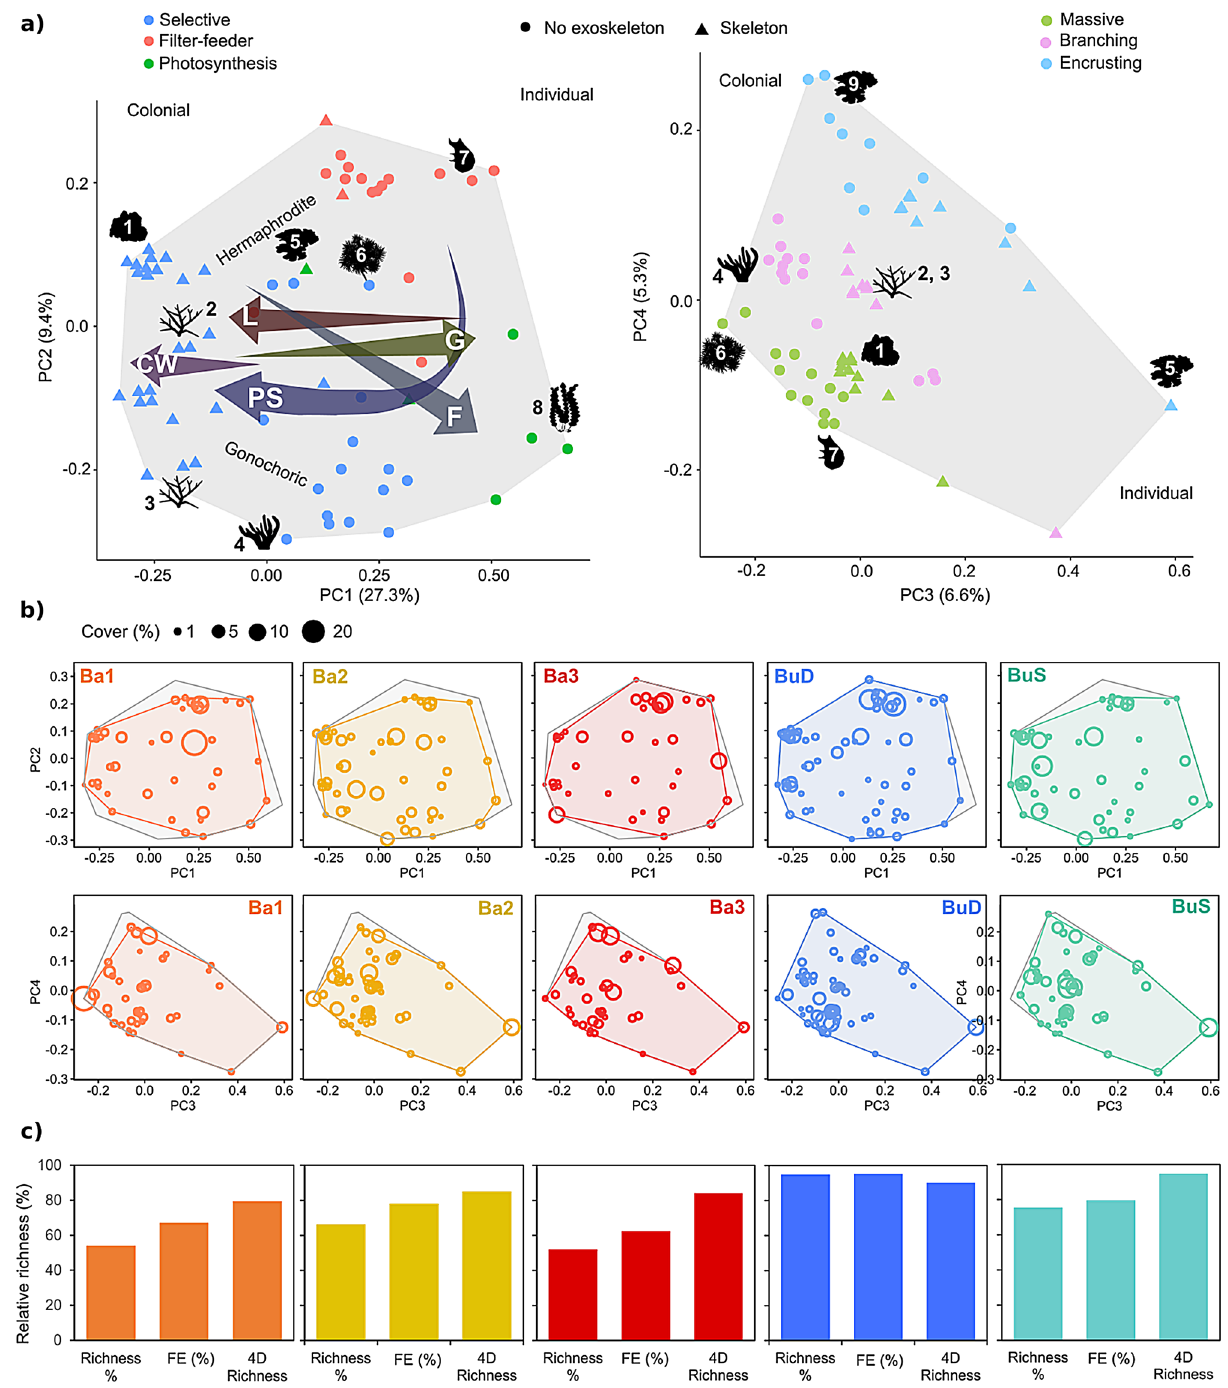
Figure 4. Benthic functional diversity of the different communities identified. ( a ) Distribution of functional entities (FEs) in the global benthic functional space, built using four PCoA axis (PC1 and PC2 left, PC3 and PC4 right) using twelve functional traits: colony formation, growth form, maximum colony size, longevity (L), growth rate (G), body flexibility (F), skeleton presence, reproductive strategy, sexual system, feeding strategy, presence of photosynthetic symbionts (PS) and corallite maximum width (CW, only for scleractinian corals). The numbers indicate the following functional entities: 1: massive hermaphrodite scleractinian corals, 2: branching hermaphrodite scleractinian corals, 3: branching gonochoric scleractinian corals, 4: Sinularia soft coral, 5: encrusting crustose coralline algae, 6: Xeniidae soft coral, 7: solitary ascidians, 8: macroalgae, 9: encrusting filter-feeders (sponges and ascidians). ( b ) Functional spaces of each of the communities analysed (coloured convex hull) superposed to the global functional space. ( c ) Functional diversity indices for each of the communities: relative taxonomic richness (Richness %), relative FE richness (FE %) and relative functional richness as % of filled global functional space (4D